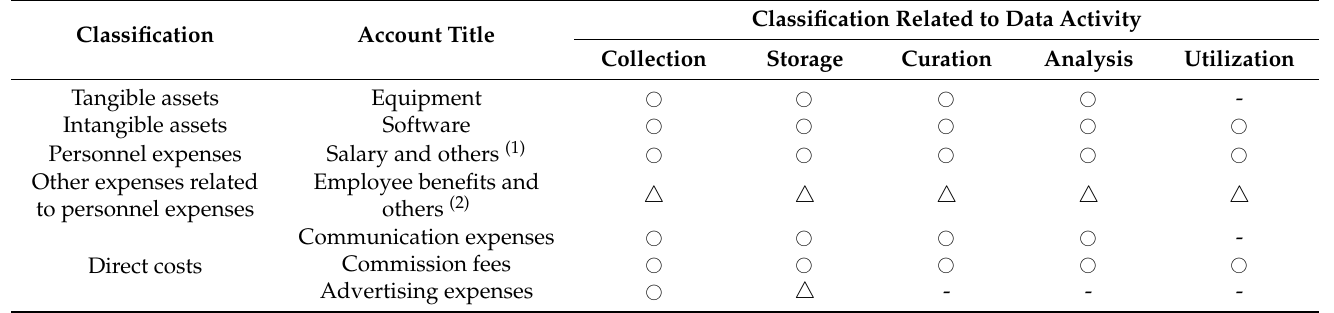
Table 1. Classification of direct and indirect costs in assets and expense accounts.